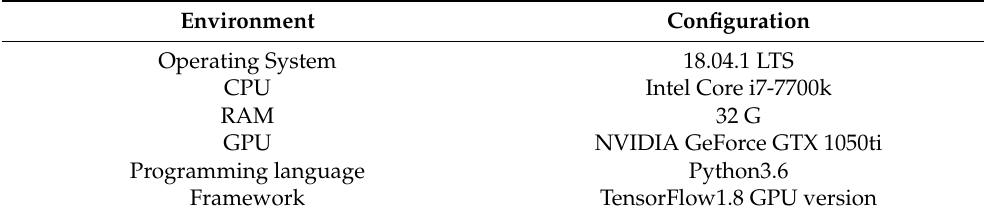
Table 1. Model running